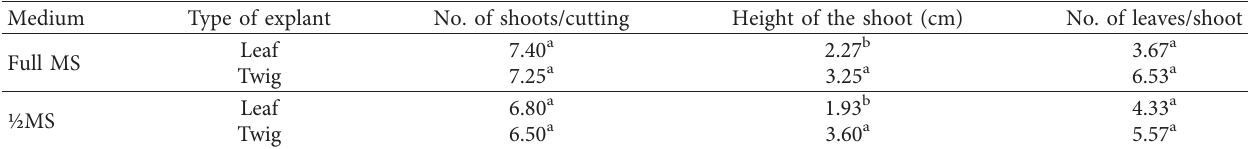
Figure 1: Scanning electron microscopy photographs of the leaf and twig explants (untreated and treated with fungicide). (a) Upper surface of leaves untreated; (b) upper surface of leaves treated; (c) lower surface of leaves untreated; (d) lower surface of leaves treated; (e) twig untreated ( × 1000); (f) twig treated ( × 1000); (g) twig untreated ( × 5000); (h) twig treated ( × 5000). The specific details of each photograph are marked as a label with each photograph. Table 1: The mean performance of the shoots under full MS and ½MS (N)